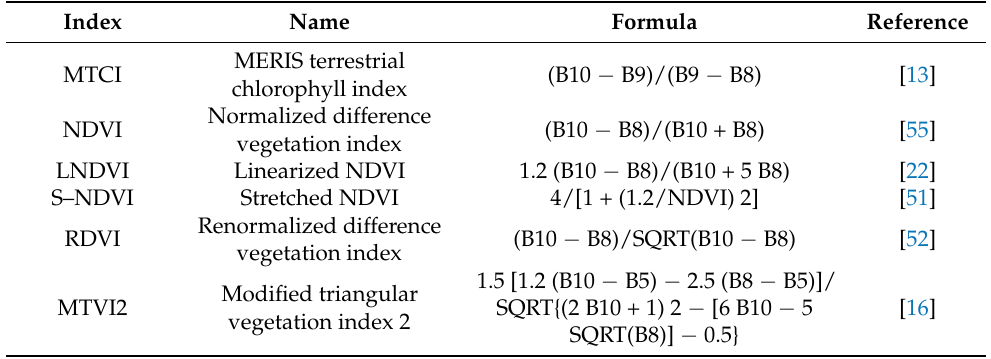
Table 4. Vegetation indices based on MERIS band settings.